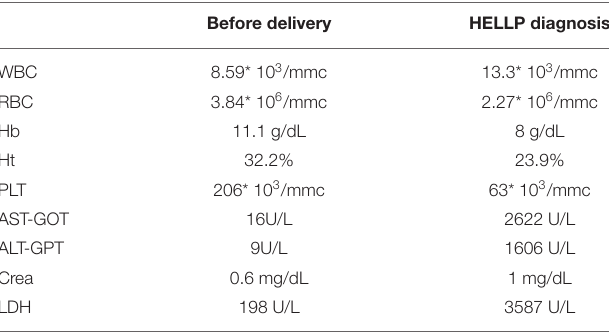
TABLE 1 | Blood test before delivery and at haemolysis, elevated liver enzymes, and low platelet count (HELLP) syndrome diagnosis. Before